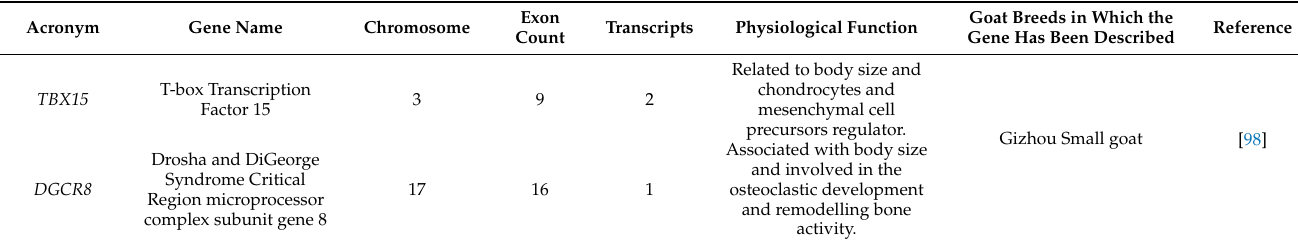
Table 3. Summary of the candidate genes associated with body size and carcass quality that have been described in goat breeds, their chromosome location, exon counts, physiological function and where to find them in the